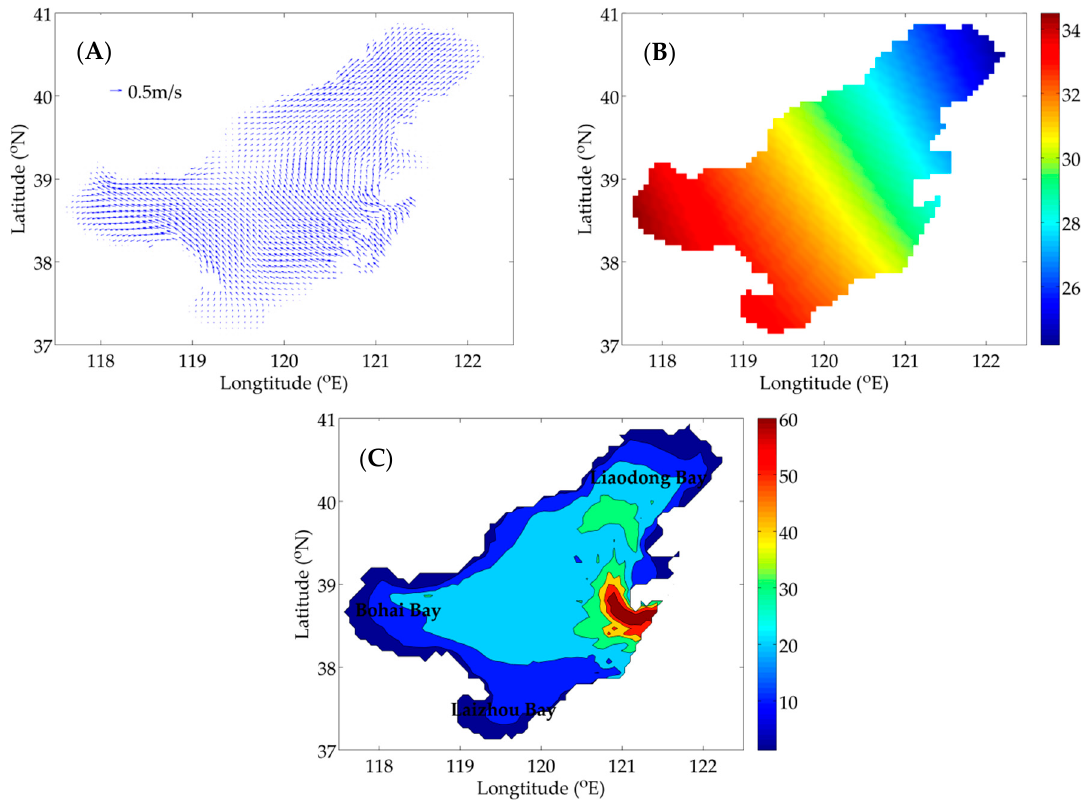
Figure 1. The surface flow field ( A ), the sea surface temperature ( B ) (unit: °C) at 12:00 (noon), 1 July 2017 and the depth ( C ) (unit: m) of the Bohai Sea.